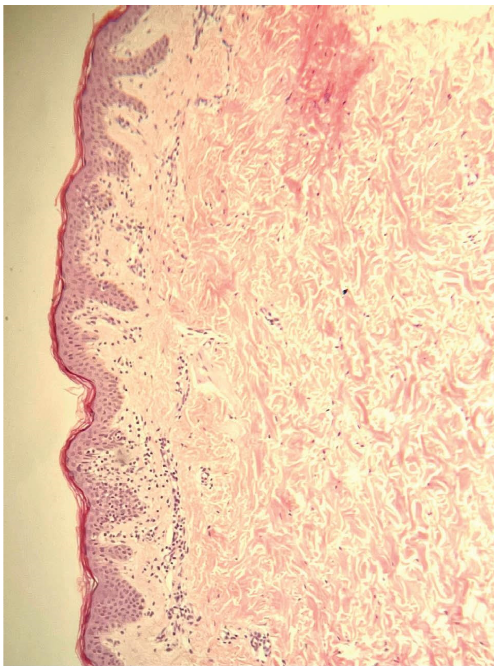
Figure 2: H&E 10x histopathology showing epidermotropism with occasional characteristic intraepidermal collections of atypical